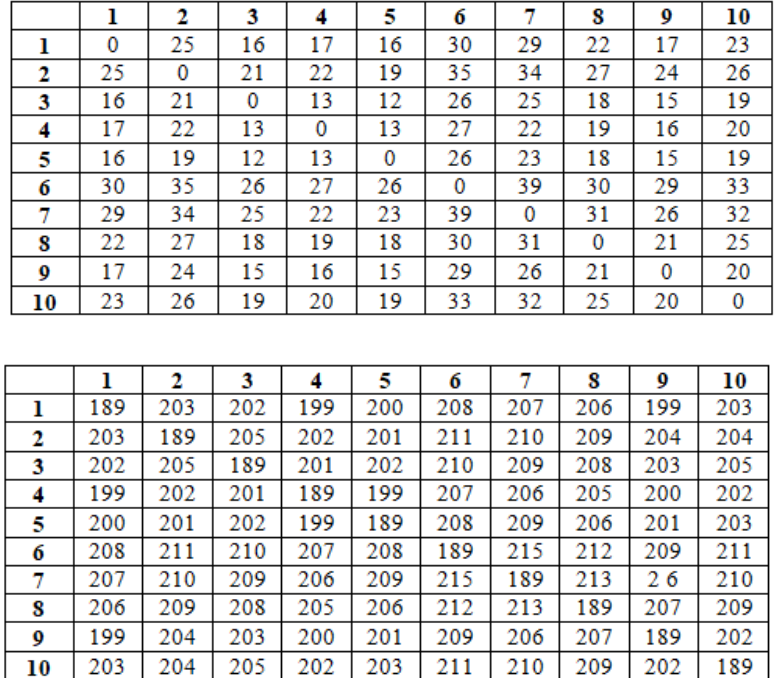
Figure 11. Distances between pairs of templates of the same device ( top ) and two different devices ( bottom ).